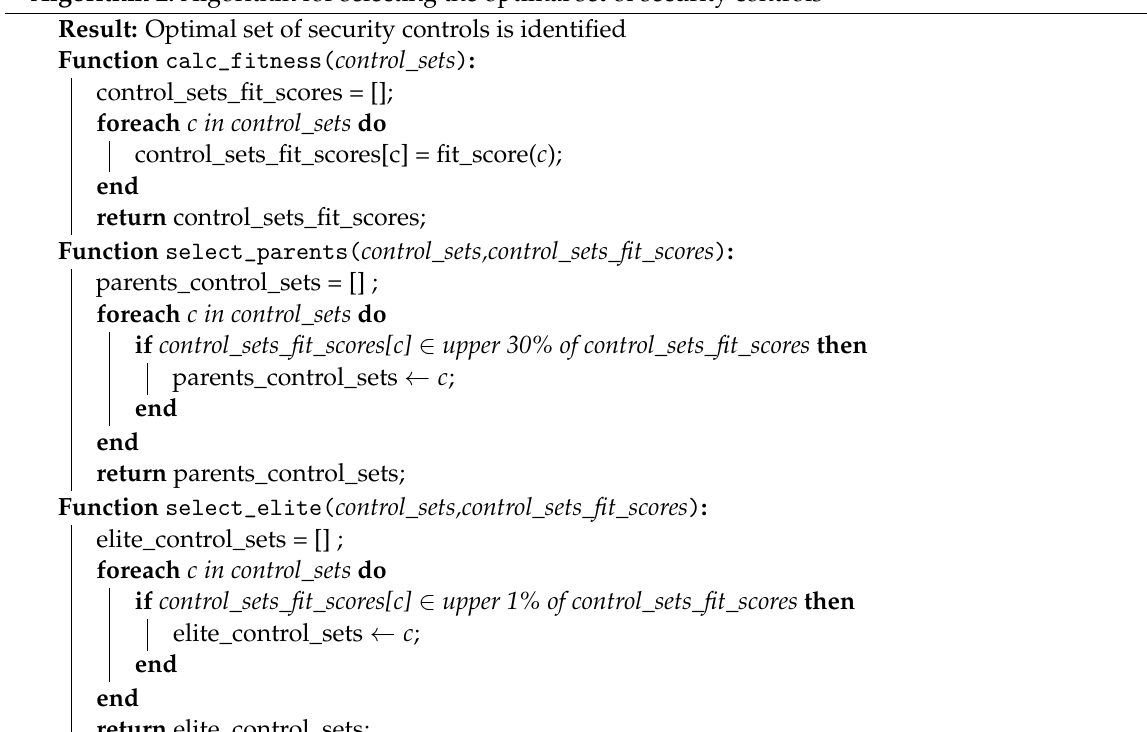
Algorithm 2: Algorithm for selecting the optimal set of security